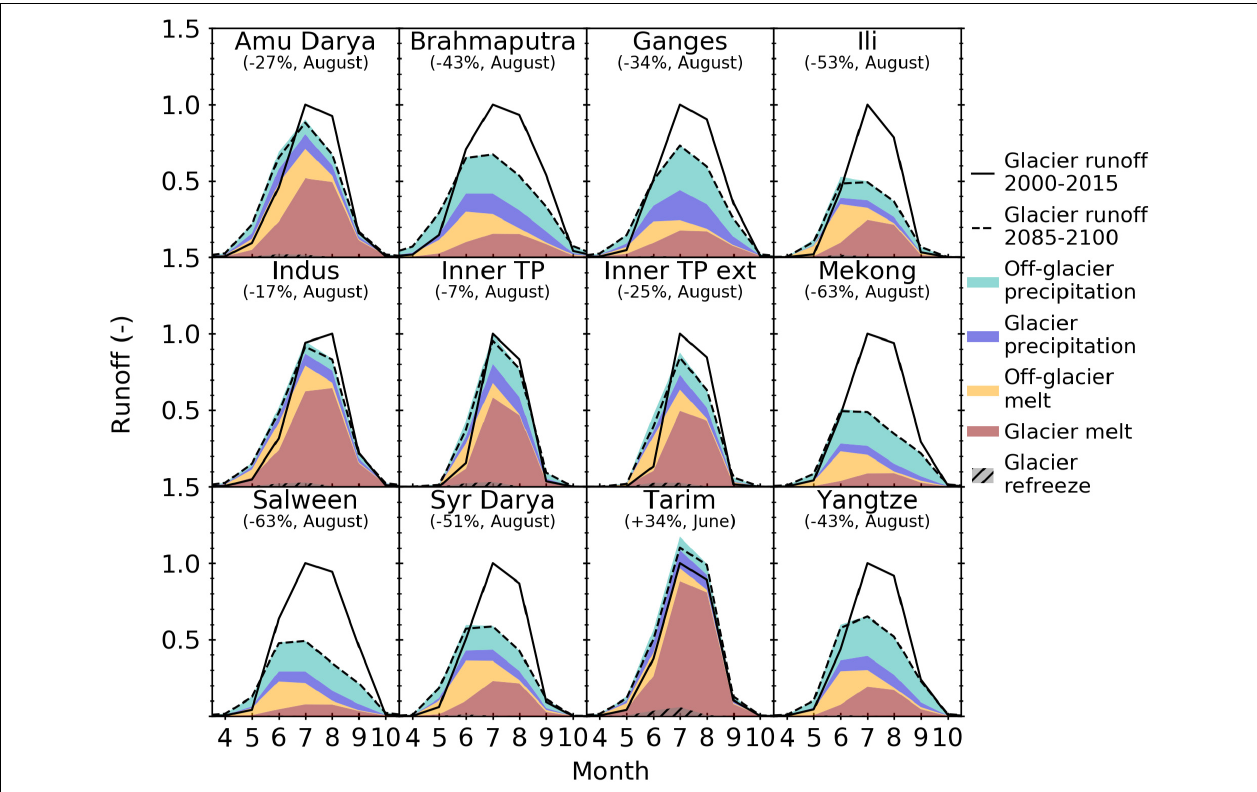
FIGURE 9 | Mean monthly fixed-gauge glacier runoff averaged over 2000–2015 and 2085–2100 for RCP 4.5. Runoff for both period averages is normalized relative to the maximum monthly runoff from 2000 to 2015. Relative contribution from various components are shown for the runoff from 2085 to 2100. Maximum monthly decrease (or, when all months show an increase, maximum increase) of runoff between June and September is given in parentheses. Results for RCP 2.6, RCP 6.0, and RCP 8.5 are shown in the Supplementary Figures S10–S12 .